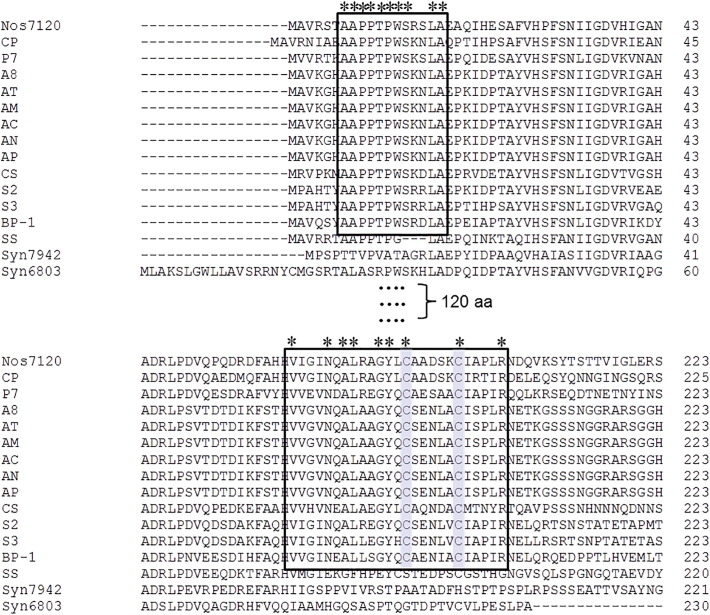
Partial alignment of CcmM amino acid sequences of 12 studied alkaliphiles with those of Synechococcus elongatus PCC 7942 (Syn7942), Synechocystis sp. PCC 6803 (Syn6803), Thermosynechococcus elongatus BP-1 (BP-1), and Nostoc sp. PCC 7120 (Noc7120) (GenBank accession no. BAA16773.1, Q03513.1, NP_681734, and BAB72822.1, respectively). The sequence order is based on the alignment. Boxes represent conserved regions of the N-terminal domain of CcmM that are assumed to be necessary for CA activity, according to Pena et al. [73]. Shaded cysteine amino acids showed essential residues participating in the disulfide bond in the C-termini of active CcmM protein. Asterisks indicate conserved amino acids inside such regions.